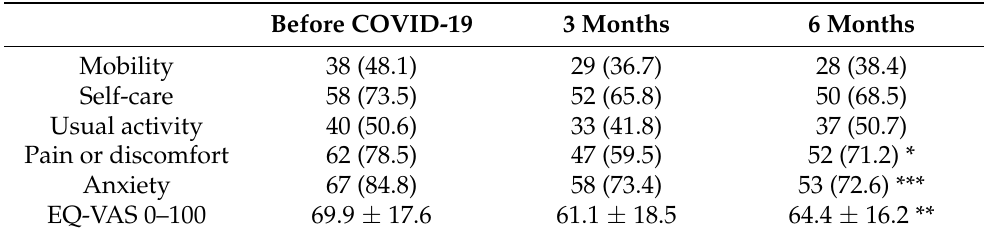
Table 4. Patients with no problems with quality of life in five dimensions of EQ-5D-5L and health related quality of life in EQ-VAS